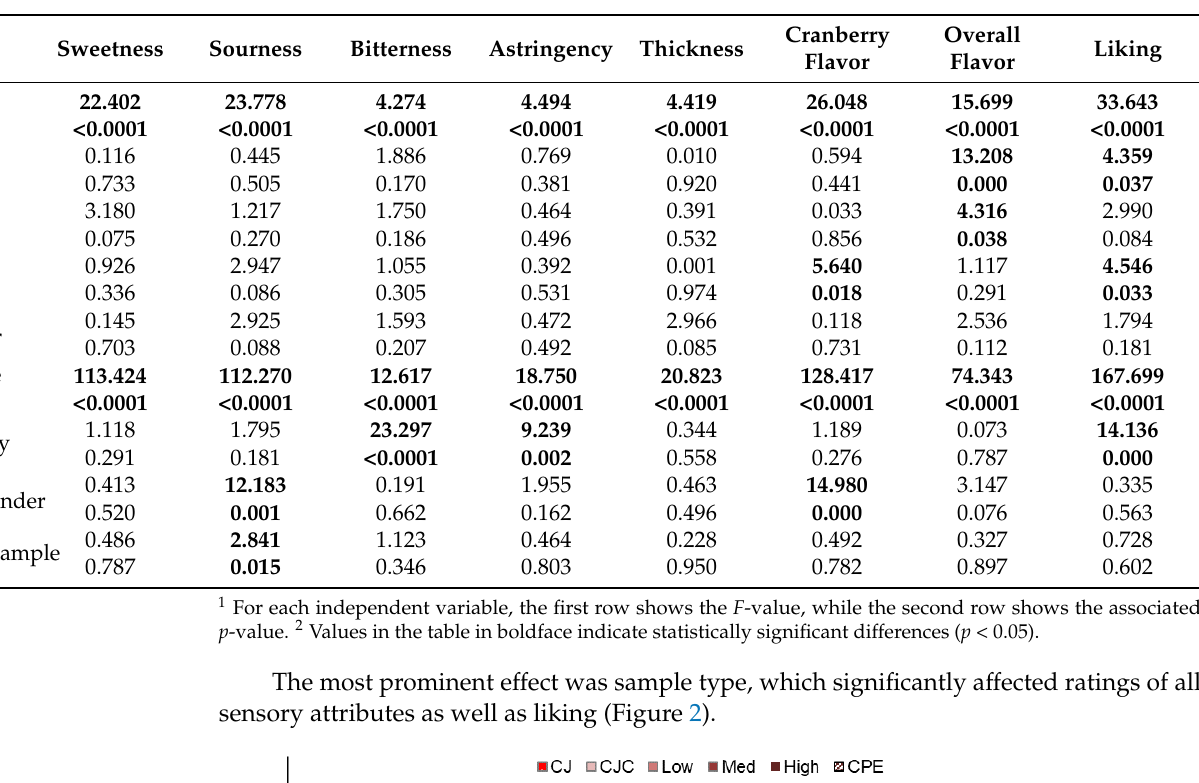
Table 3. ANCOVA model results. Effects of main factors (Sample Type, PROP Taster Status, Gender and Ethnicity) on sensory attribute intensity and overall liking ratings of cranberry juice cocktail samples when adjusted for covariates (Age, BMI). * Only significant interactions are shown 1,2 .